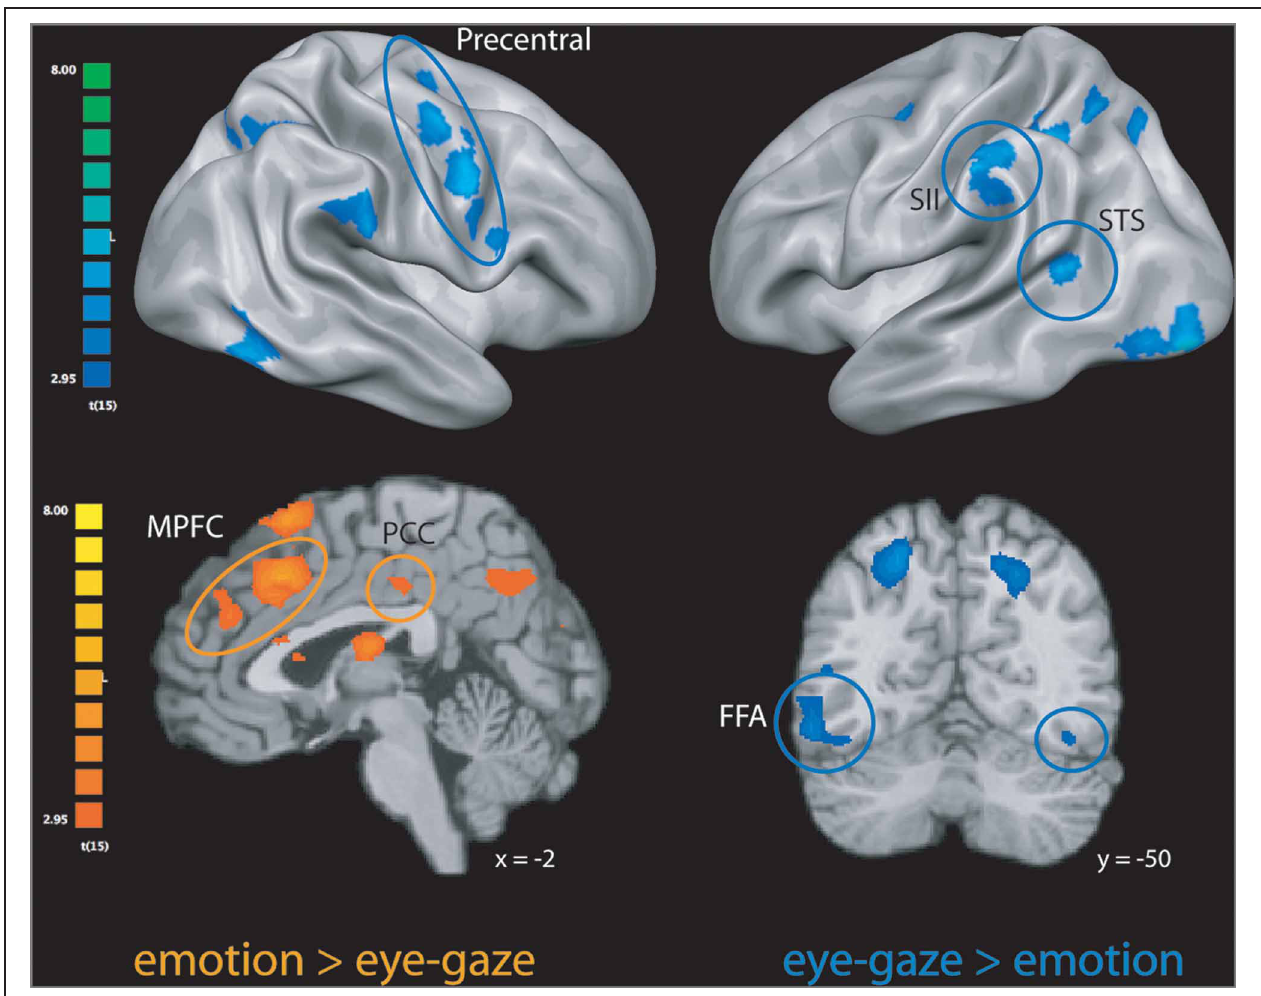
cingulate cortex. All clusters exceed a significance thresholded of p < 0 . 005, uncorrected, with an extent threshold of at least 30 voxels, corresponding with a threshold of p < 0 . 05, corrected as computed using Monte Carlo